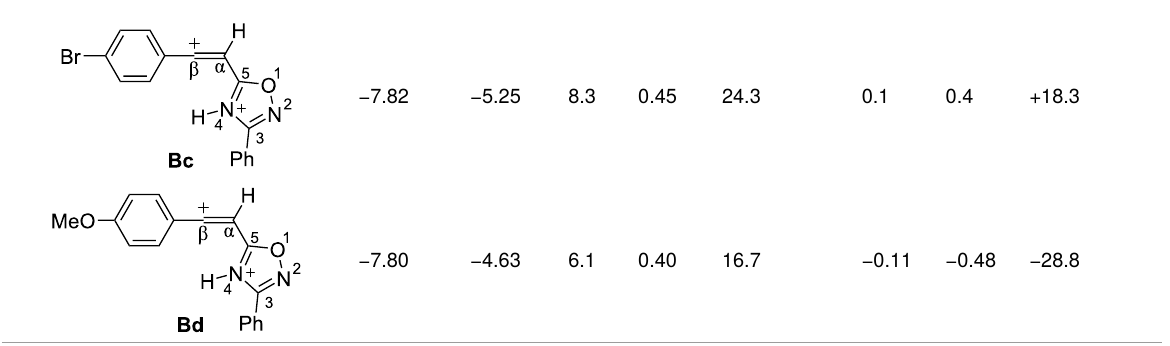
Table 1: Selected electronic characteristics for cations Aa–d and Ba–d calculated by DFT from protonation of oxadiazoles 3a–d .